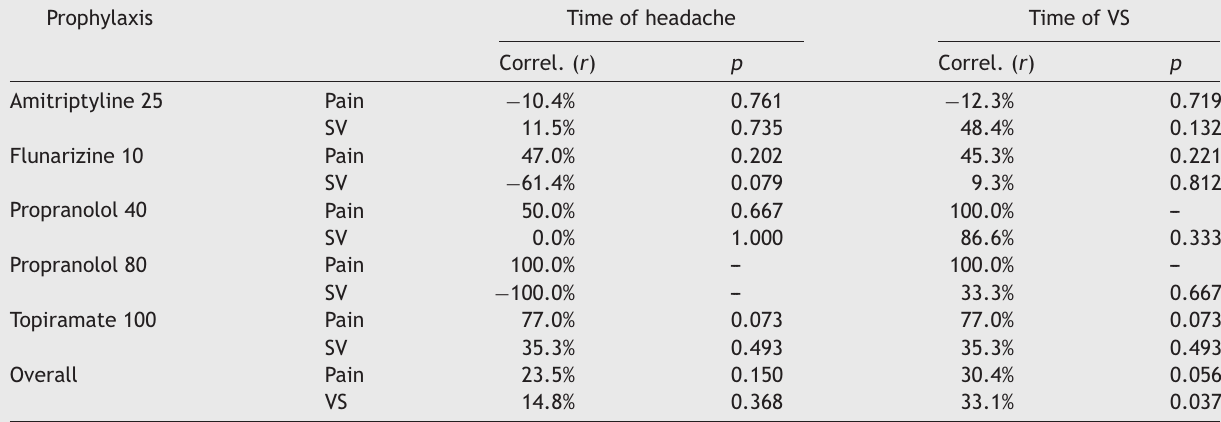
Statistical correlation between the response to therapy assessed by VAS after prophylactic treatment in patients with VM and time of symptoms (migraine and